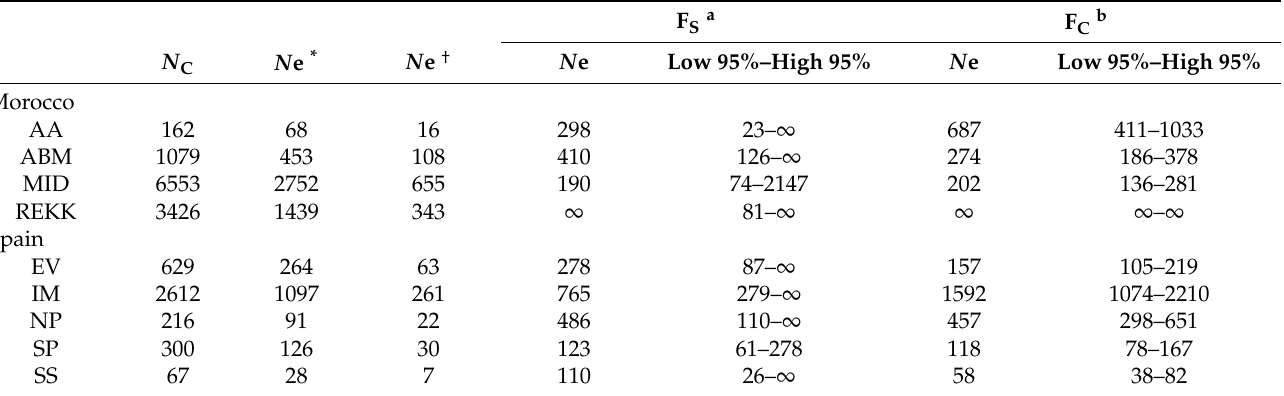
Table 2. Summary of effective population size (Ne) estimates and 95% CI (parametric bootstrap) for each region using the temporal methods (F S , F C ) implemented in NeEstimator v2.1 [57]. The census size (N C ) and the Ne of each region assuming different Ne/N C ratios observed in scientific reviews is also